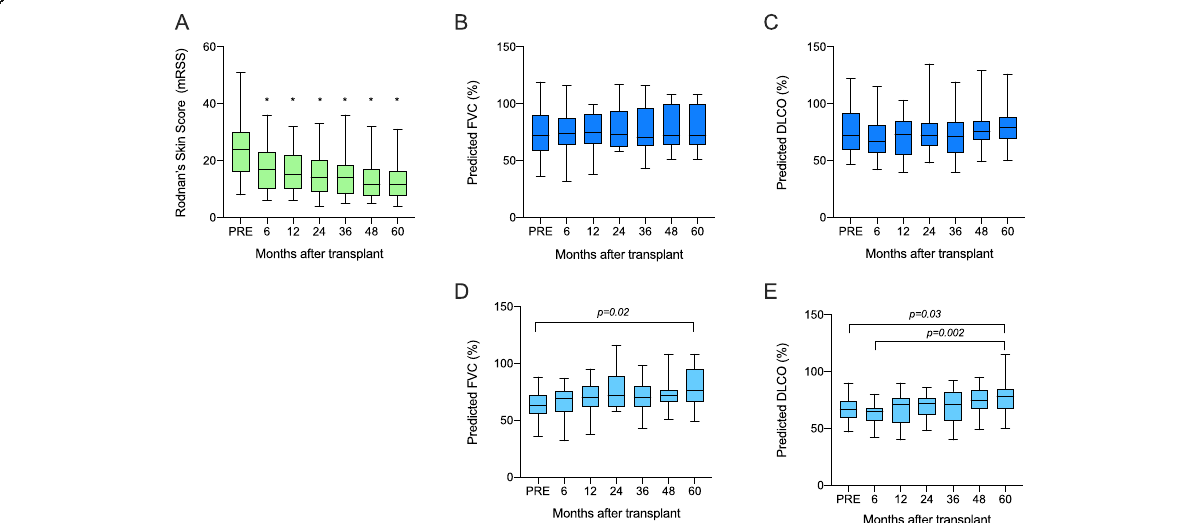
Fig. 4 Clinical Outcomes over 5-year follow-up after transplantation. a Modified Rodnan ’ s Skin Score before and periodically after autologous hematopoietic stem cell transplantation (HSCT). * indicates significant diferences between baseline (PRE) and post-HSCT time points: PRE vs 6 months, p = 0.007; PRE vs 12 months, p = 0.0006; PRE vs 24, 36, 48 and 60 months, p < 0.0001. b Predicted forced vital capacity (FVC) percentages before and periodically after autologous HSCT in all patients included in the study. c Predicted percentages of diffusing capacity of lung carbon monoxide (DLCO) before and periodically after autologous HSCT in all patients included in the study. d Predicted FVC percentages before and periodically after autologous HSCT in the subset of patients with progressive interstitial lung disease at enrollment for transplantation. e Predicted percentages of diffusing capacity of lung carbon monoxide (DLCO) before and periodically after autologous HSCT in patients with progressive interstitial lung disease at enrollment for transplantation. Box plot limits indicate 25th to 75th percentiles; lines within boxes indicate the median and whiskers mark the 10th and the 90th